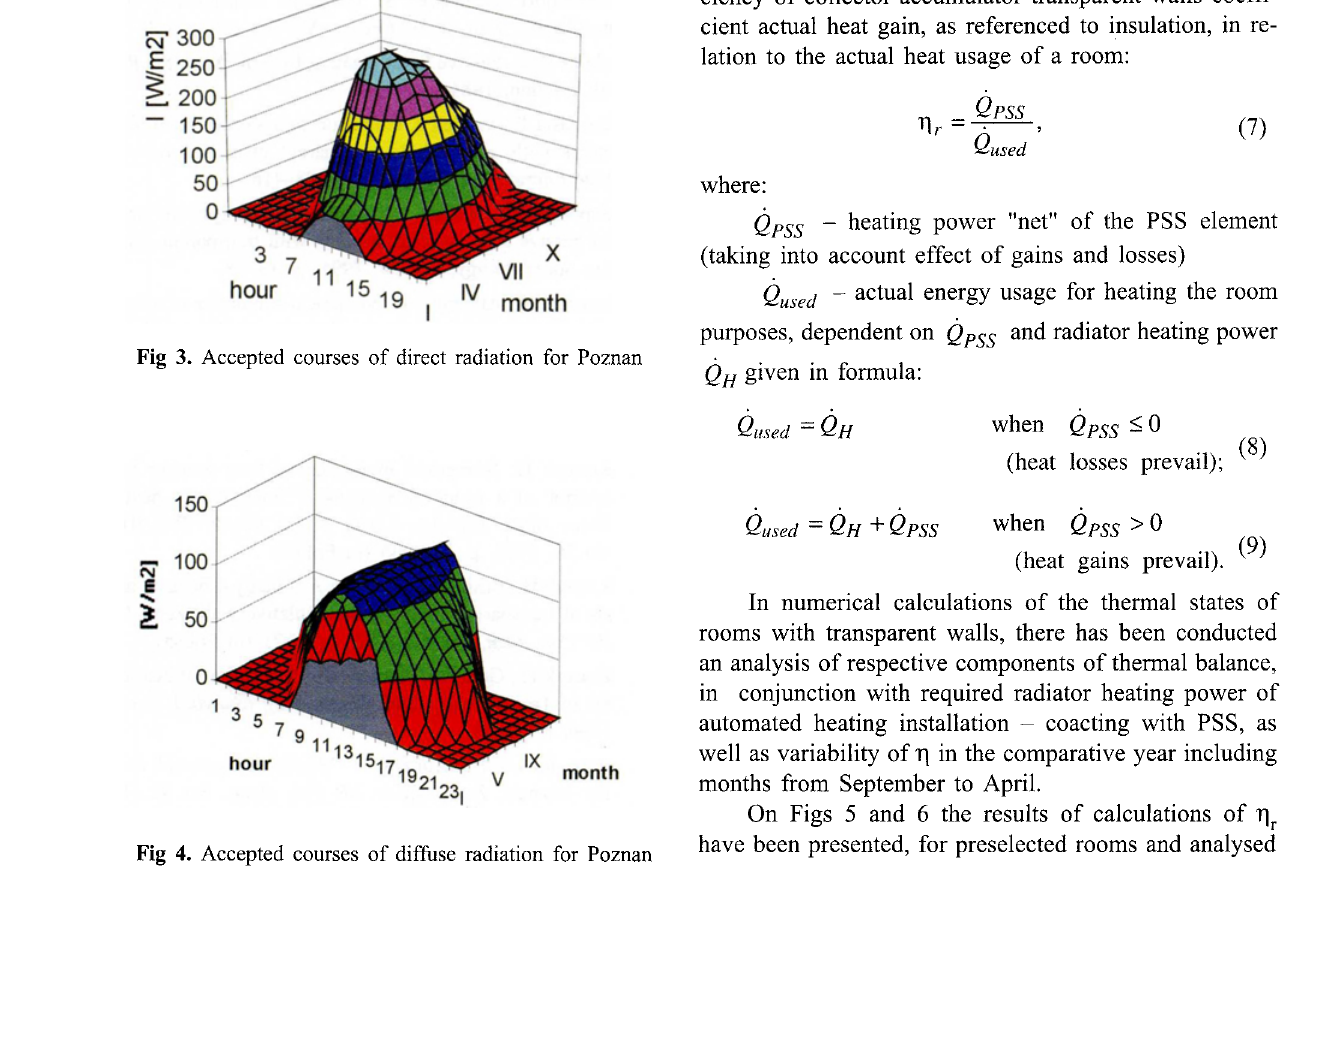
Fig 3. Accepted courses of direct radiation for Poznan